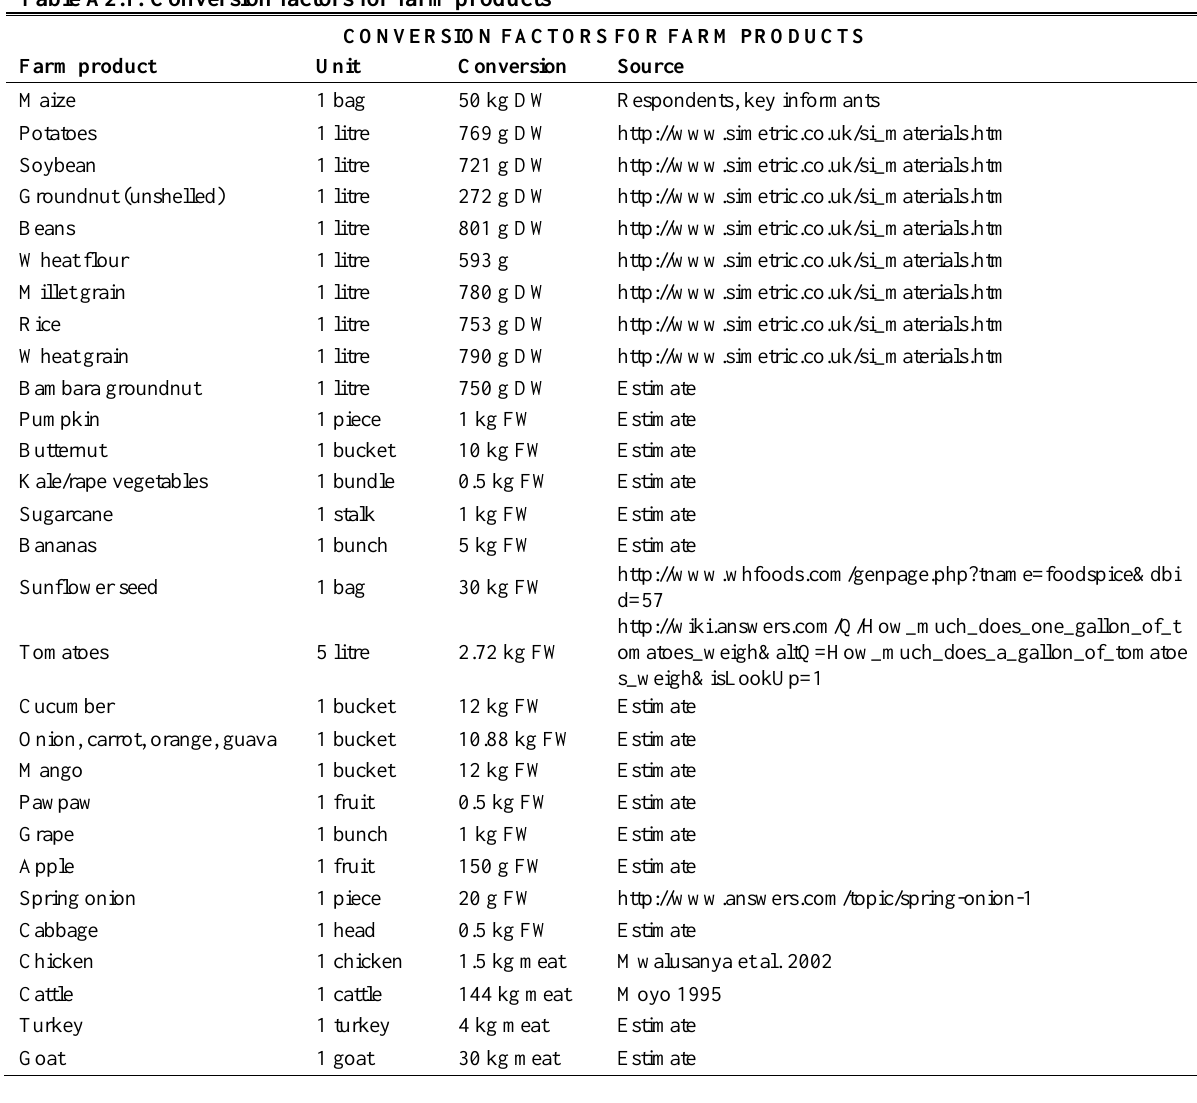
Table A2.1: Conversion factors for farm products